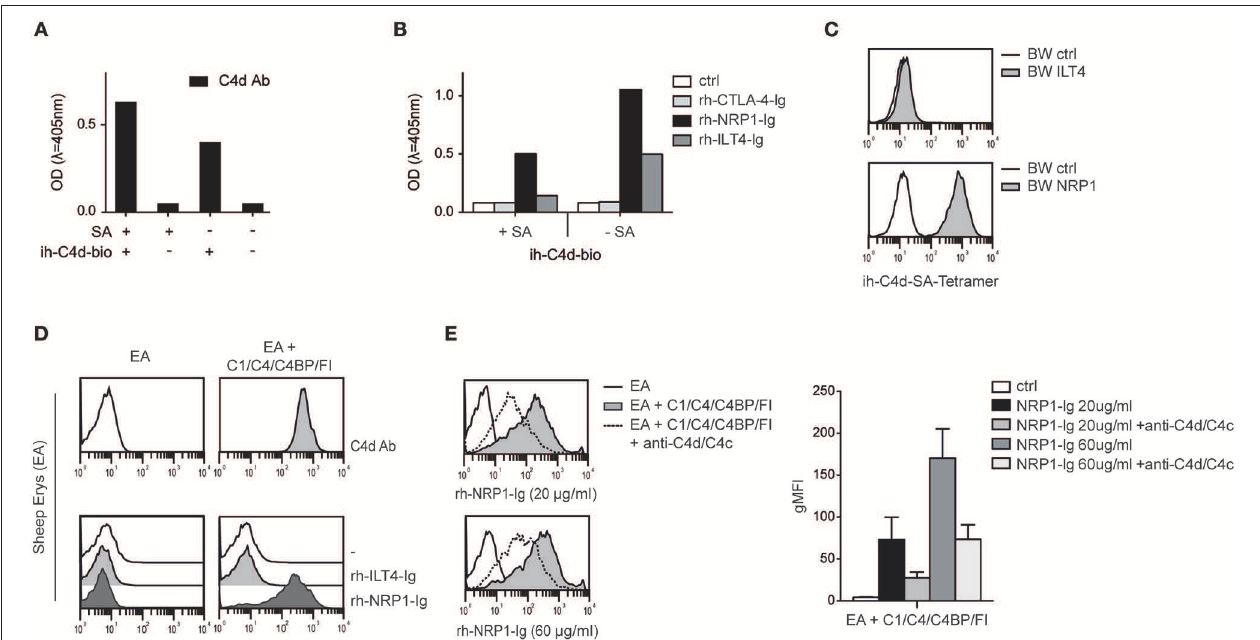
FIGURE 4 | Interaction between NRP1 and C4d deposited to surfaces via thioester binding following classical complement activation. (A) C4d biotinylated at its intrinsic thioester carbonyl via amine-PEG2-biotin reagent (ih-C4d-bio) was immobilized to a solid phase either via streptavidin ( + SA) or in random orientation without SA (–SA) and detected by ELISA using a monoclonal C4d antibody. (B) Interaction between C4d, immobilized to a solid phase as shown in (A) , and rh-NRP1-Ig and rh-ILT4-Ig. Rh-CTLA-4-Ig fusion proteins and goat anti-human-IgG (ctrl) served as negative controls. (C) C4d biotinylated via its intrinsic thioester was tetramerized using streptavidin-APC and probed with BW cells expressing ILT4 or NRP1 and analyzed via flow cytometry. (D) Antibody-coated sheep erythrocytes (EA) bearing C4d were prepared using purified C1, C4, C4 binding protein (C4BP), and factor I (FI) as described in Material and Methods. Deposition of C4d was detected with a monoclonal C4d antibody (upper panel). Interaction between C4d-loaded EA and control EA with immunoglobulin fusion proteins (rh-ILT4-Ig; rh-NRP1-Ig) is shown in the lower panel. (E) Binding of goat anti-human-IgG (ctrl) or rh-NRP1-Ig (20 or 60 µ g/ml) to C4d-EA in the presence or absence of an anti-C4d and anti-C4c antibodies. Data shown are representative for two independently performed experiments. gMFI, geometric mean of fluorescence